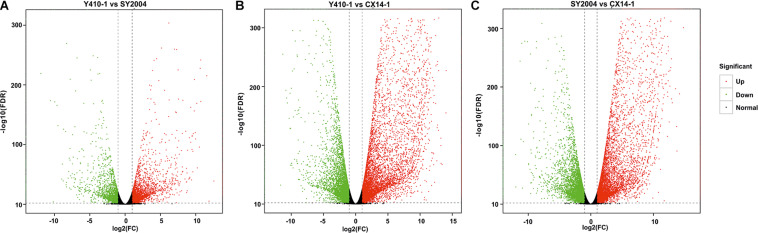
Volcano plots of differentially expressed genes (DEGs) for each comparison in flower bud of early- and late-bolting Chinese cabbage double haploid lines. The x and y axes indicate logarithm fold change [log2(FC)] of the difference in the expression of a gene between two samples and the negative logarithm of the statistical significance [log2(FDR)] of the change in gene expression, respectively. The red and green dots represent significantly up- and downregulated genes, respectively; while black dots represent non-differentiated genes. FC, fold change; FDR, false discovery rate.